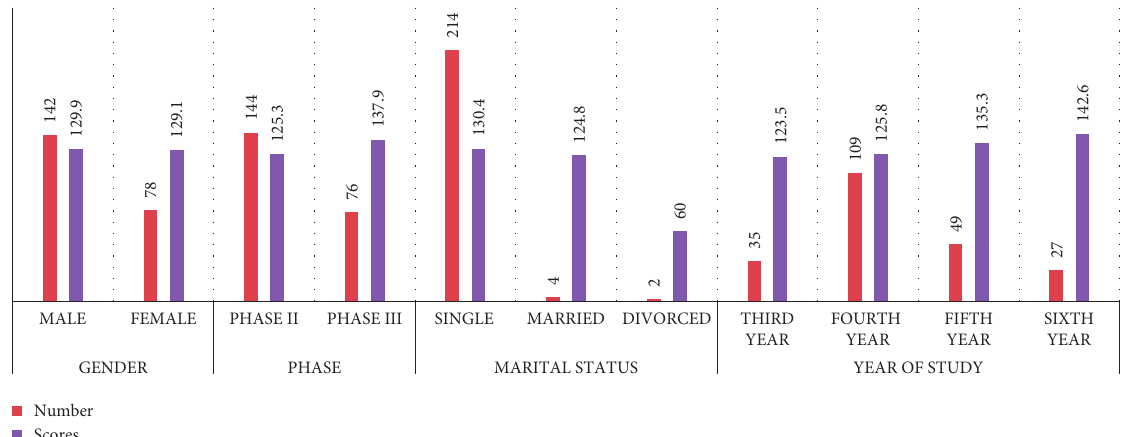
Figure 2: Diagram showing the scores in the DREEM questionnaire as per the demographic characteristics of